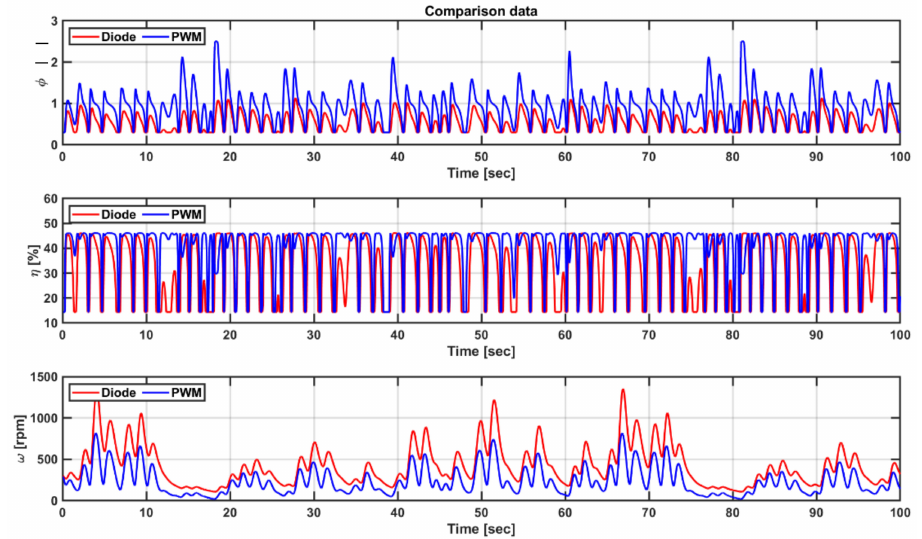
Figure 23. Turbine performance results of PTO system in the integration simulation under irregular waves ( v t = 0~30 m / s and Tp = 4.75 s).